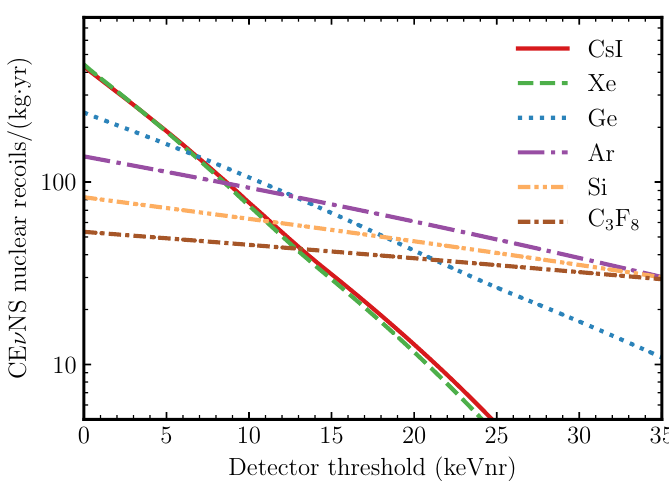
Figure 7 . Expected integrated CE (cid:23) NS rate above nuclear recoil threshold, 20 m away from the ESS target, for all detector materials considered in this work. All technologies considered for use at the ESS have thresholds at or below 1 keV nr